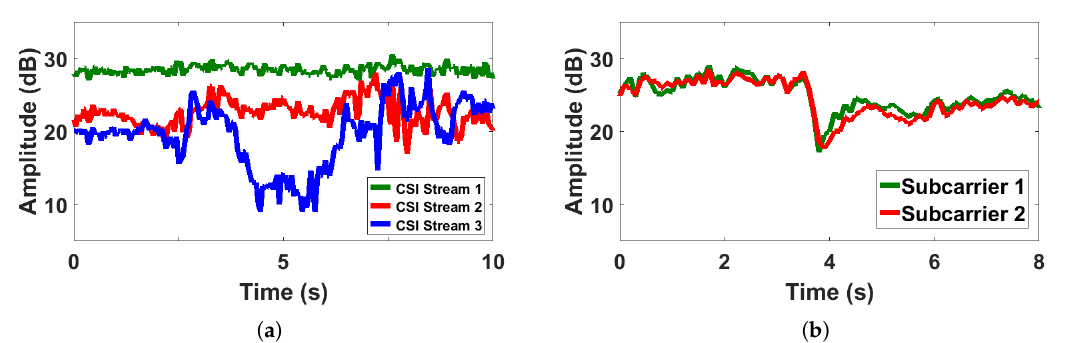
Figure 3. Human motion affects the CSI streams independently while affects different subcarriers in a similar way. ( a ) Shows the CSI variances of the first subcarrier in different streams when human motion occurs, while ( b ) shows the CSI variances of different subcarriers in one stream.